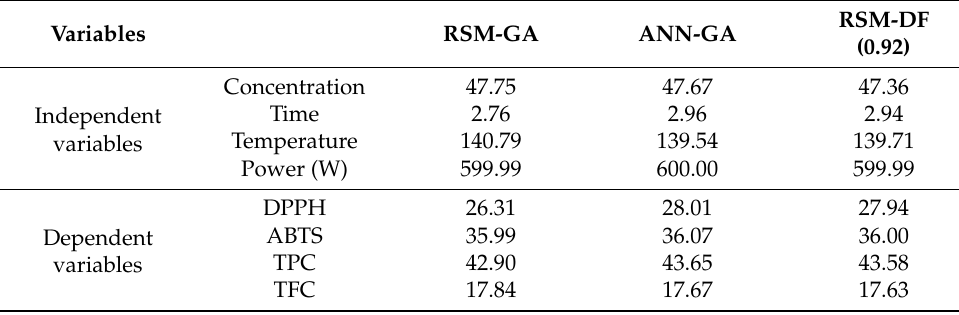
Table 4. Process optimization using three different